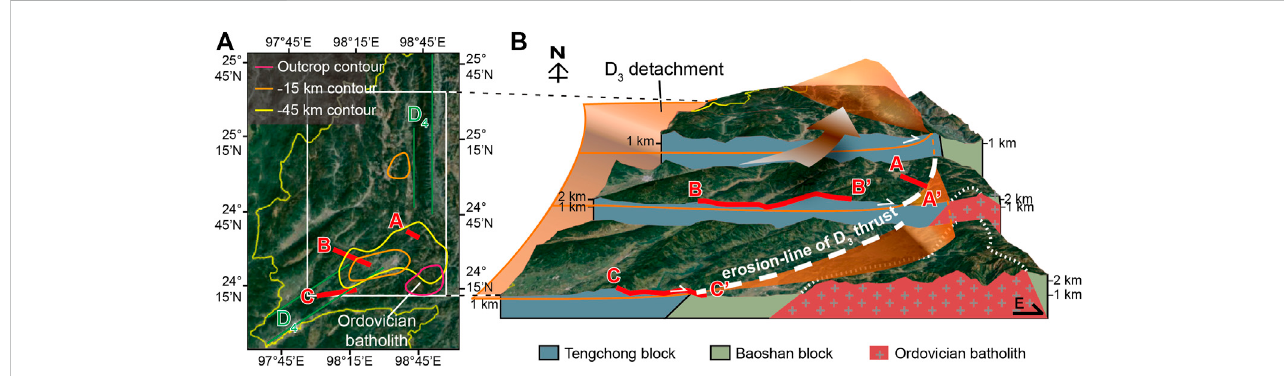
FIGURE 10 Satellite image and 3D-block topography diagram showing major structures and geological units around the Gaoligong orocline. (A) Satellite image shows the location of the high-resistivity Ordovician basement (Ye et al., 2020). The red line marks the surface exposure of the Ordovician basement, the orange line marks the boundary at a depth of 15 km, and the yellow line marks the boundary at a depth of 45 km. The green line marks the strike of D 4 shear belts. (B) 3D-block diagram showing the curvature of the Gaoligong orocline produced by intersecting the topography surface to the shoveled shape thrust shear plane against the Ordovician